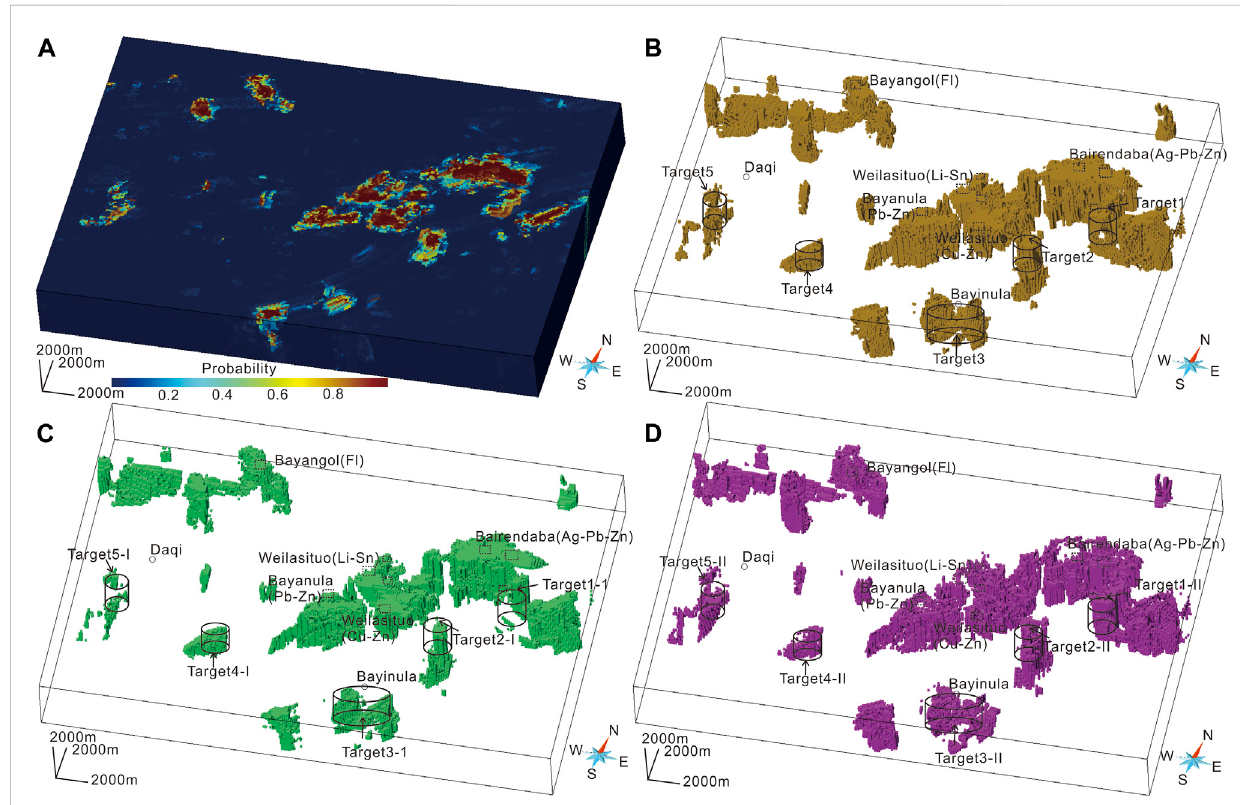
FIGURE 13 (A) 3D mineral probability map of the XGBoost11 predictive model; and (B) targets by P-A plot; (C) Ⅰ -level targets and (D) Ⅱ -level targets by C-A